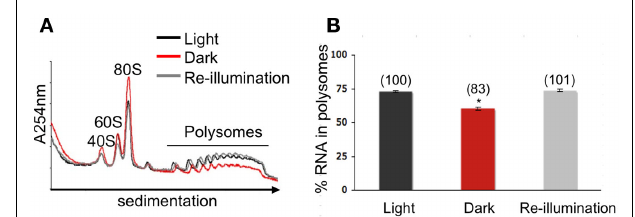
FIGURE 2 | Reversible global adjustment of protein synthesis in response to altered light availability. (A) Quantitative sucrose density gradient analysis of ribosomal subunit and polysome complex levels.Whole seedlings were pulverized under liquid nitrogen, hydrated in a membrane-disrupting and ribosome-stabilizing buffer, and centrifuged to obtain a ribosome pellet.The ribonucleoprotein complexes were re-suspended and separated by centrifugation through 20–60% sucrose density gradients. Absorbance profiles at 254nm were recorded.The ribosomal subunit and polysome peak areas were quantified after adjustment of the absorbance profiles to equivalent total optical density units per gradient. Line traces show representative absorbance profiles of fractionated ribosomes of seedlings shifted to darkness for 1h (red), re-illuminated for 10min (gray), and maintained in the light (black). (B) Mean (in percent) cellular RNA content in polysome complexes, calculated from three independent biological replicate experiments. Error bars represent SD and an asterisk indicates a significant difference from the seedlings maintained in the light, as determined by Student’s t -test ( p < 0.05). Numbers in brackets above each bar are the percent polysome